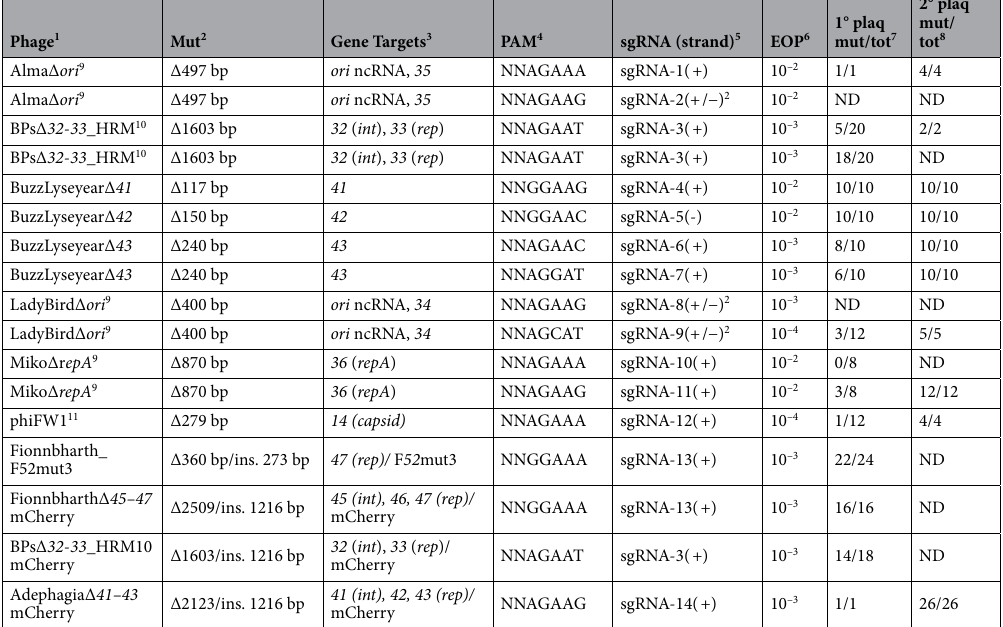
Table 1. Recovery of engineered phages using CRISPY-BRED. 1 Name of the desired phage recombinant. 2 Mutation (Mut) indicates the type of mutation (∆; deletion, ins; insertion) and sizes thereof. 3 Deleted/ inserted genes with putative gene functions in parentheses (int, integrase; rep, immunity repressor). 4 The PAM site for each sgRNA is shown. 5 For some constructions two sgRNA were tested for the same target genome; ( +) or (−) indicates whether the template ( +) or non-template (−) strand is targeted; (+ /−) indicates RNA transcripts are present on both strands. See Supplementary Table 1 for sequences. 6 EOP, Efficiency of plaquing, as determined by differences in phage titers on ATc induced and uninduced media. 7 Number of primary mutant plaques from the total tested. ND, Not Determined. 8 Number of secondary mutant plaques from the total tested. ND, Not Determined. 9 As described in reference 25 25 . 10 Two slightly different BPs derivatives that carry host range mutations were engineered to have the same deletion. 11 Phage phiFW1 is a derivative